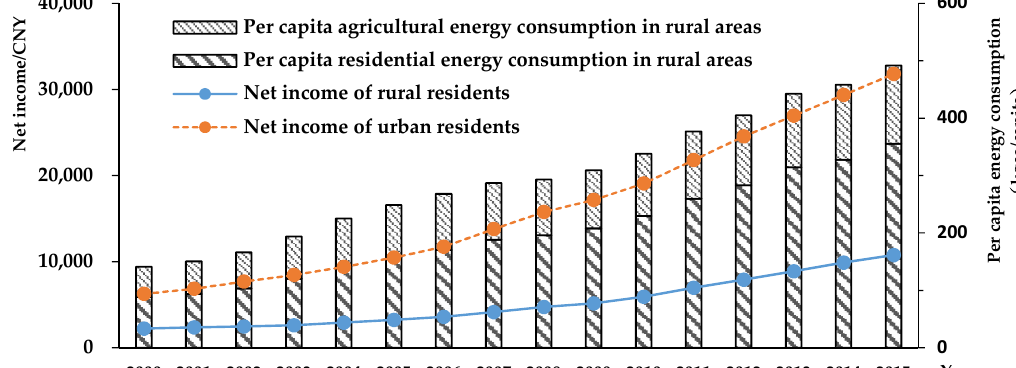
Figure 4. Income and per capita energy consumption in China from 2000–2015 (lines refer to the left Y-axis and columns refer to the right Y-axis).